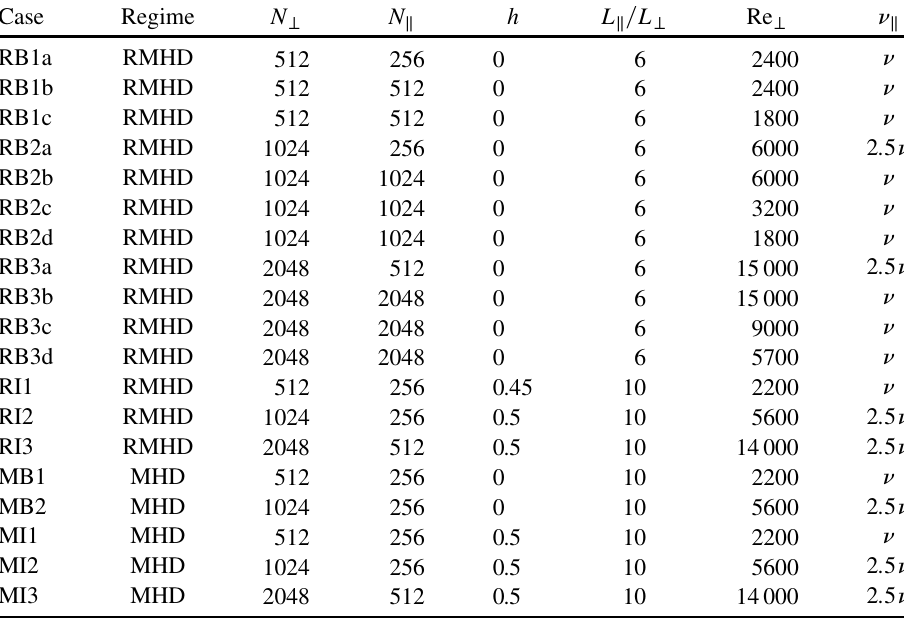
TABLE I. Simulation parameters: Summary of the numerical runs with different numerical resolutions and different Reynolds numbers. No particular scheme is used to choose the Reynolds number for a given resolution other than to ensure that the studied scaling properties are well demonstrated and the numerical runs are